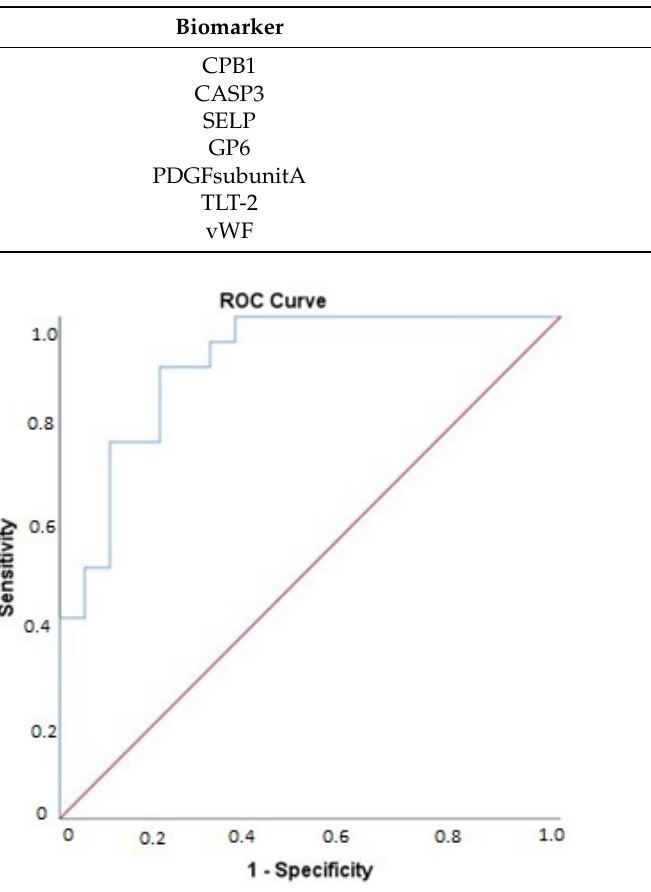
Figure 3. ROC curve for the elastic net model. Biomarkers included are CPB1, CASP3, SELP, GP6, PDGF-subunit A, TLT2, and vWF. AUC 0.91 (95% CI: 0.82–0.99, p < 0.001).